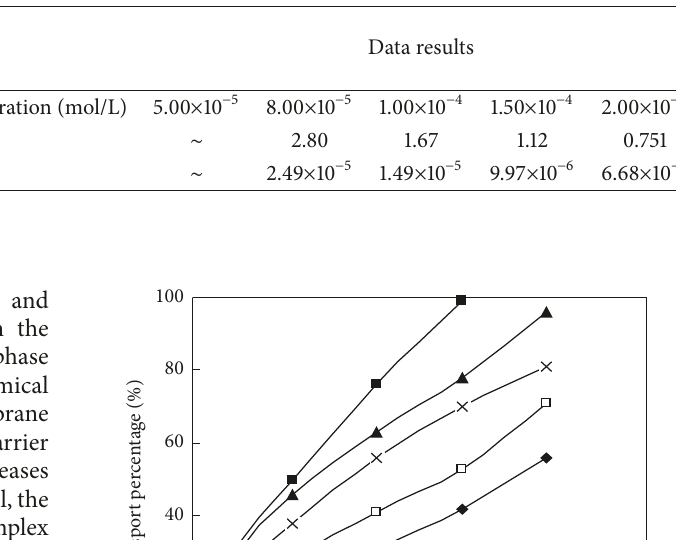
Table 4: Effect of initial concentrations on transport of rare earth.